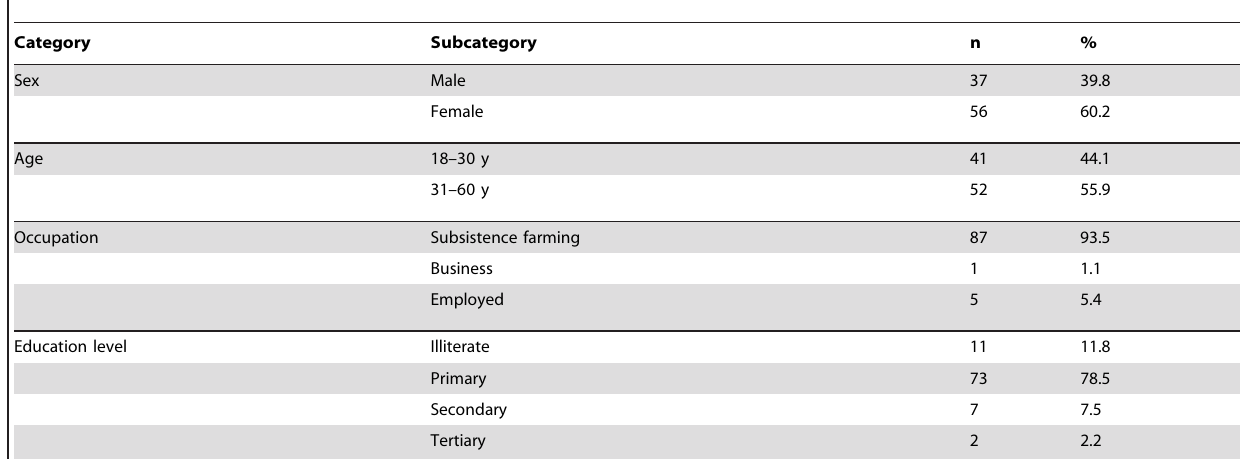
Table 1. Demographic characteristics of FGD